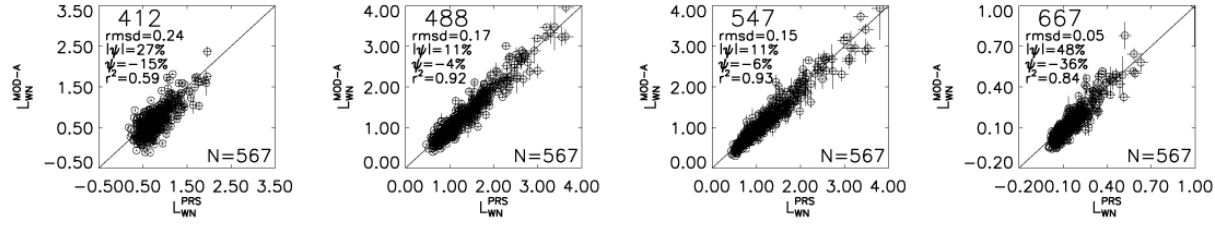
Fig. 8. As in Fig. 7 but for MODIS-A (MOD-A).